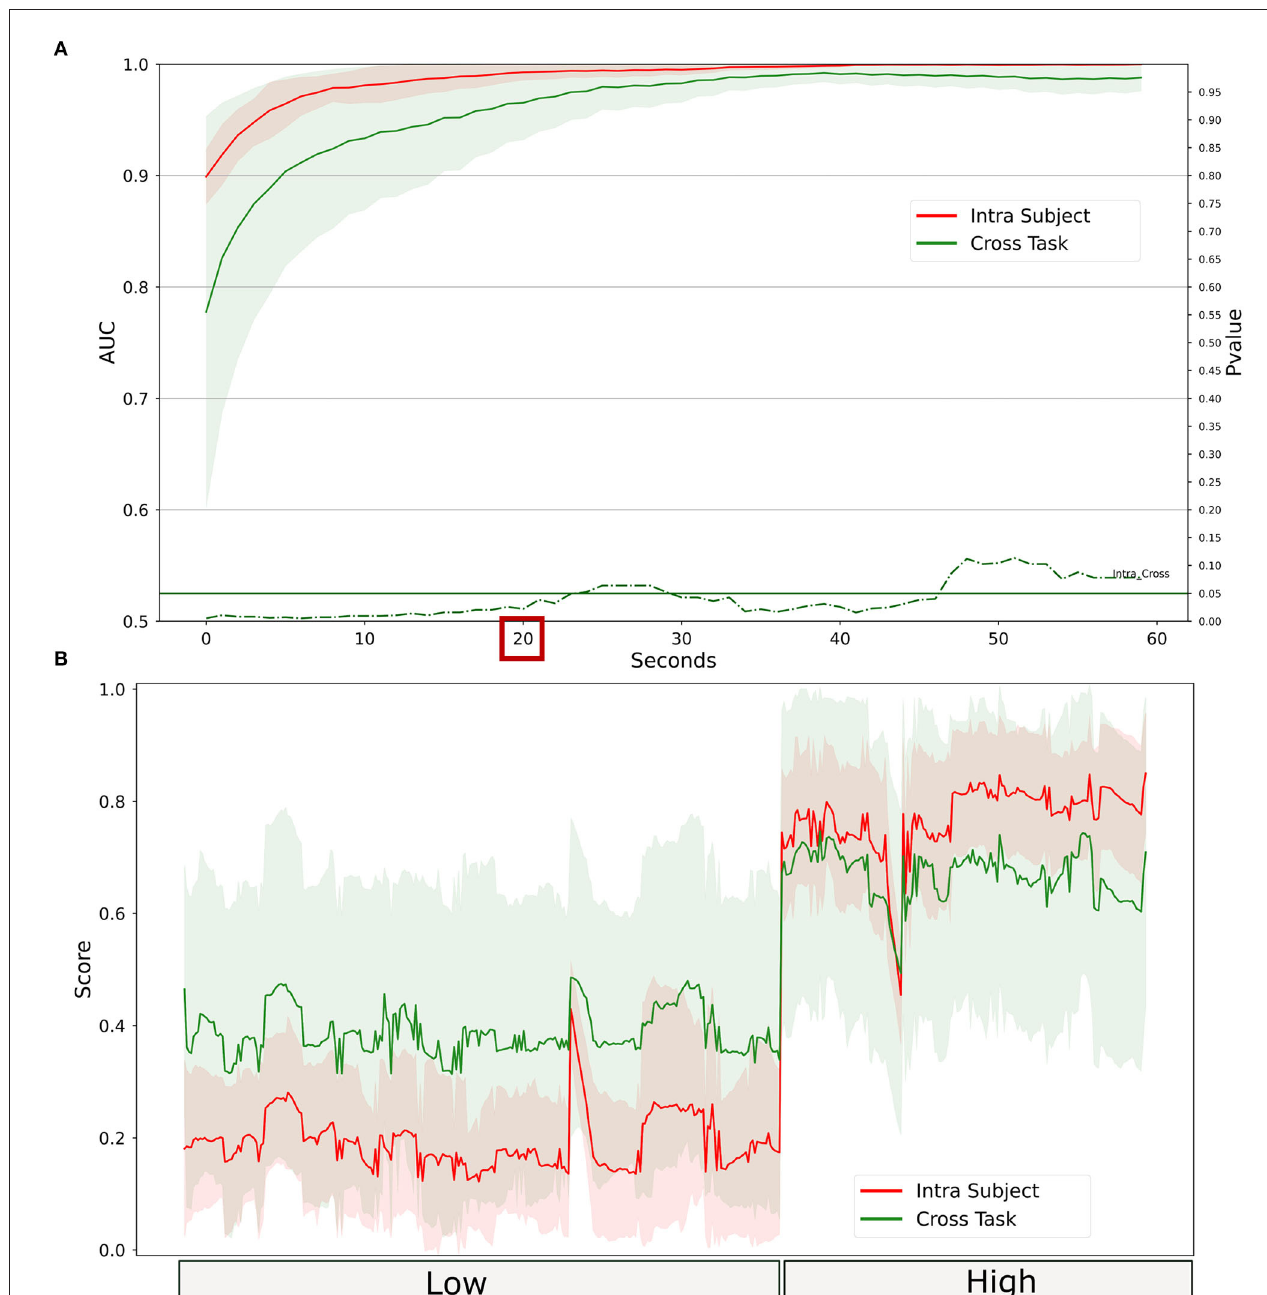
FIGURE 12 | Comparison between intra-subject and cross-task calibration for stress discrimination in a realistic setting. (A) AUC values obtained by water electrodes through intra-subject (red) and cross-subject (green) calibration for different time resolutions (1–60s). The solid lines represent the median of the AUC among the participants. The shadows represent the mean absolute deviation of the AUC across participants. The dashed green line represents the results in terms of p -values of the Wilcoxon signed-rank test. The threshold of significance ( p = 0.05) has been highlighted in the same color. (B) The stress index obtained from each of the two models at 20s of temporal resolution. The line represents the average over the population, and the shadow represents the standard